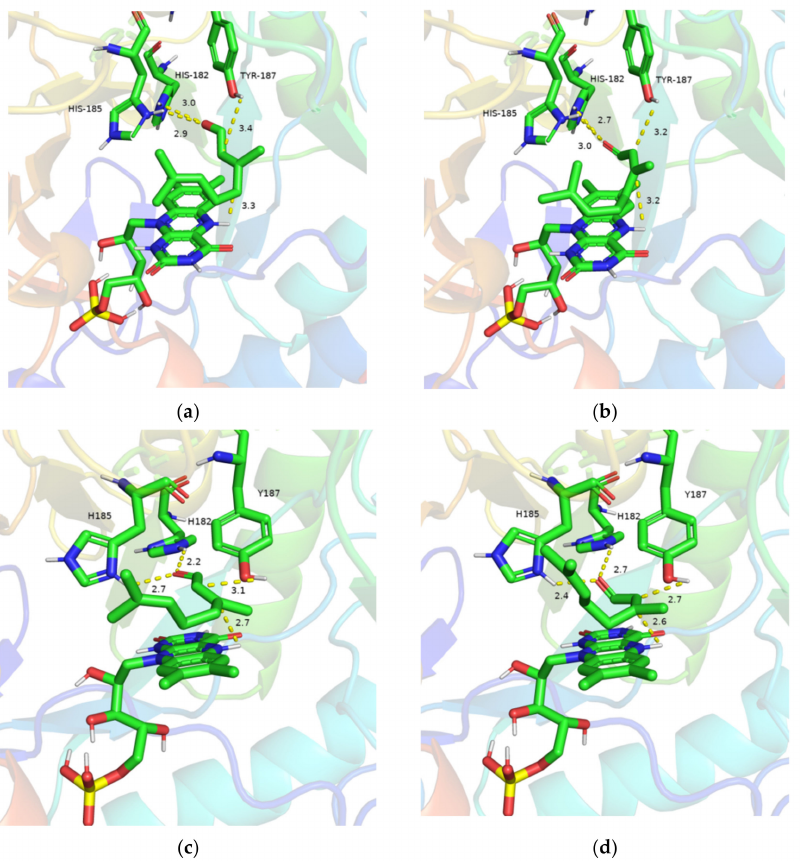
Figure 4. Molecular docking of old yellow enzyme (NemR-PS or its variant D275G/F351A) and the substrate ( Z )-citral or ( E )-citral. ( a ), NemR-PS and ( Z )-citral; ( b ), NemR-PS and ( E )-citral; ( c ), NemR-PS variant D275G/F351A and ( Z )-citral; ( d ), NemR-PS variant D275G/F351A and ( E )-citral. Green, carbon atom; blue, nitrogen atom; tangerine, oxygen atom; white, hydrogen atom; yellow, phosphorus